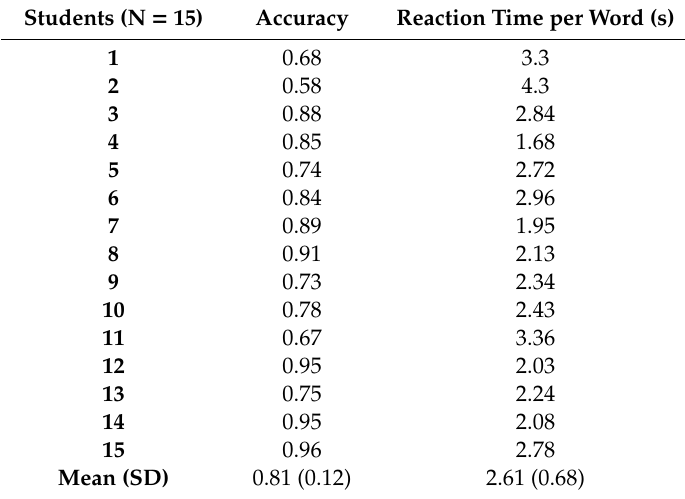
Table 2. Accuracy and average reaction time in the vocabulary